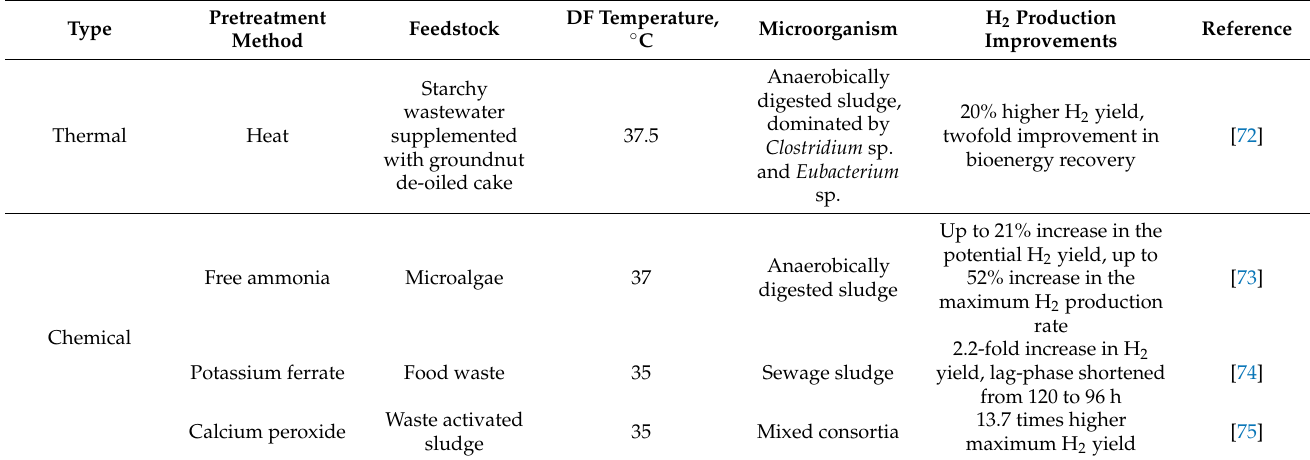
Table 4. Enhancement of H 2 production through various types of feedstock